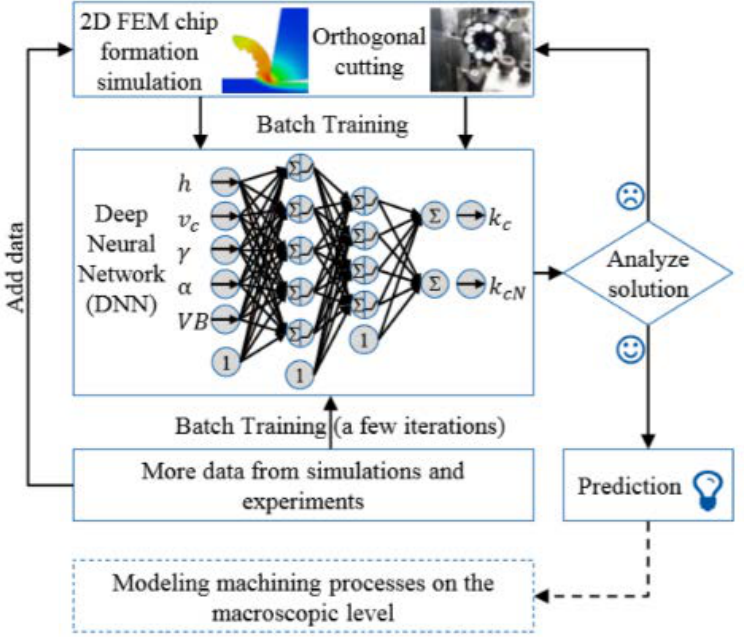
Figure 1. Hybrid approach on machine-learning architecture [51] .